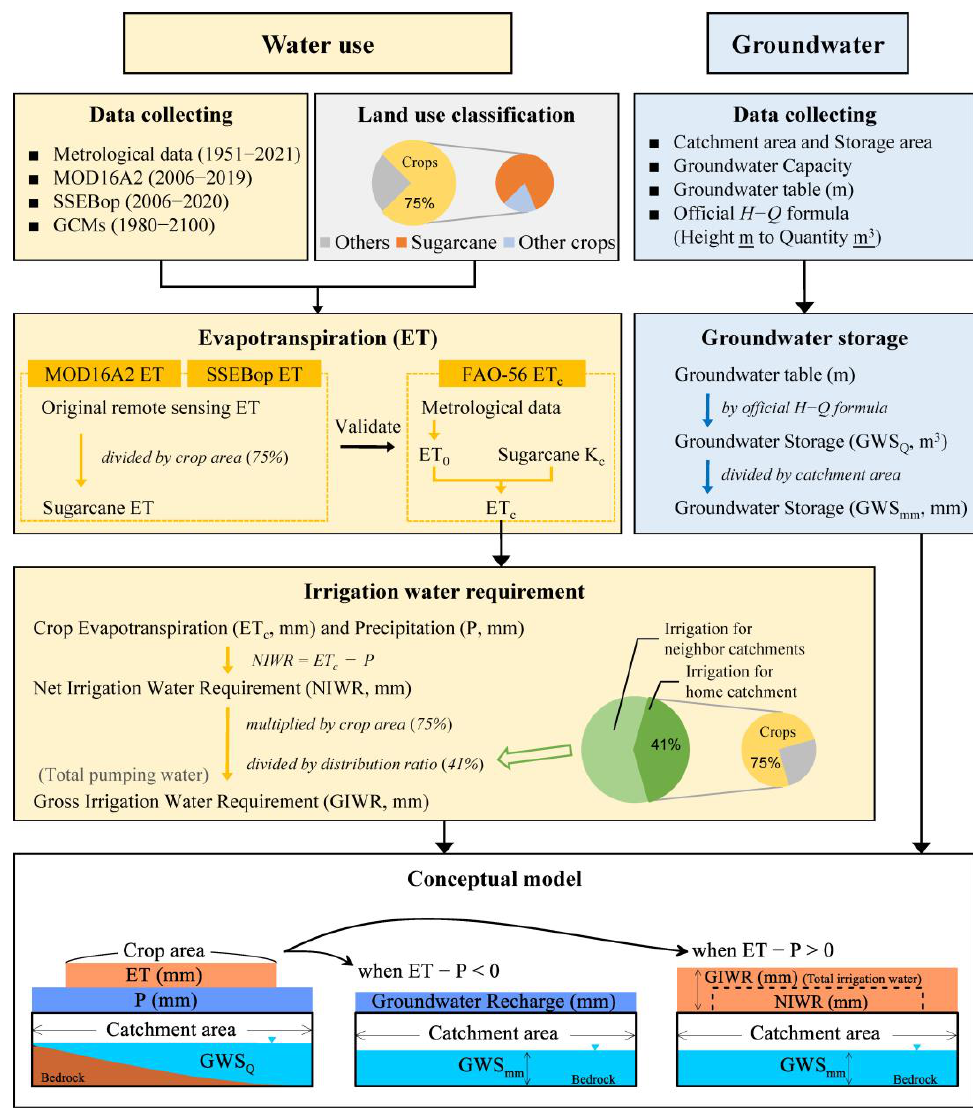
Figure 2. Flow chart of the methodology for the estimation of irrigation water requirement and influence on groundwater storage. The estimation of irrigation water requirement is based on a joint approach of FAO-56 for ET c and MODIS ET.